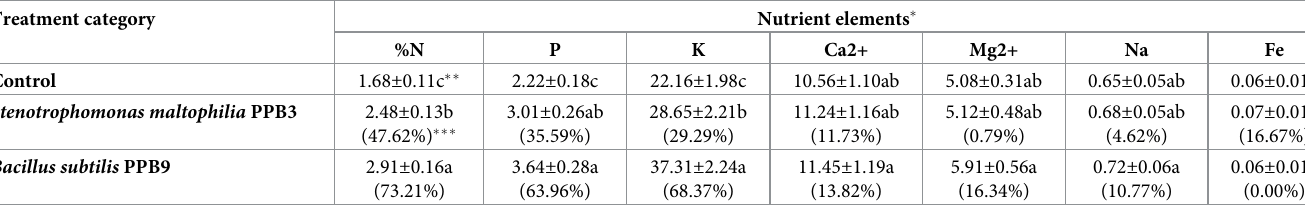
Table 4. Effects of S . maltophilia PPB3 and B . subtilis PPB9 strains on nutrient concentrations in tomato leaves. Treatment